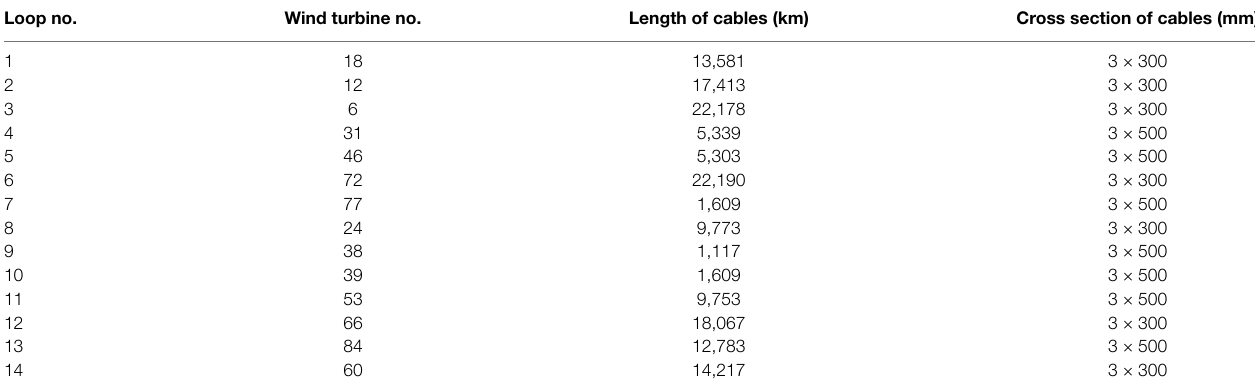
TABLE 1 | Information of the connected wind turbines and their offshore submarine cables. Loop